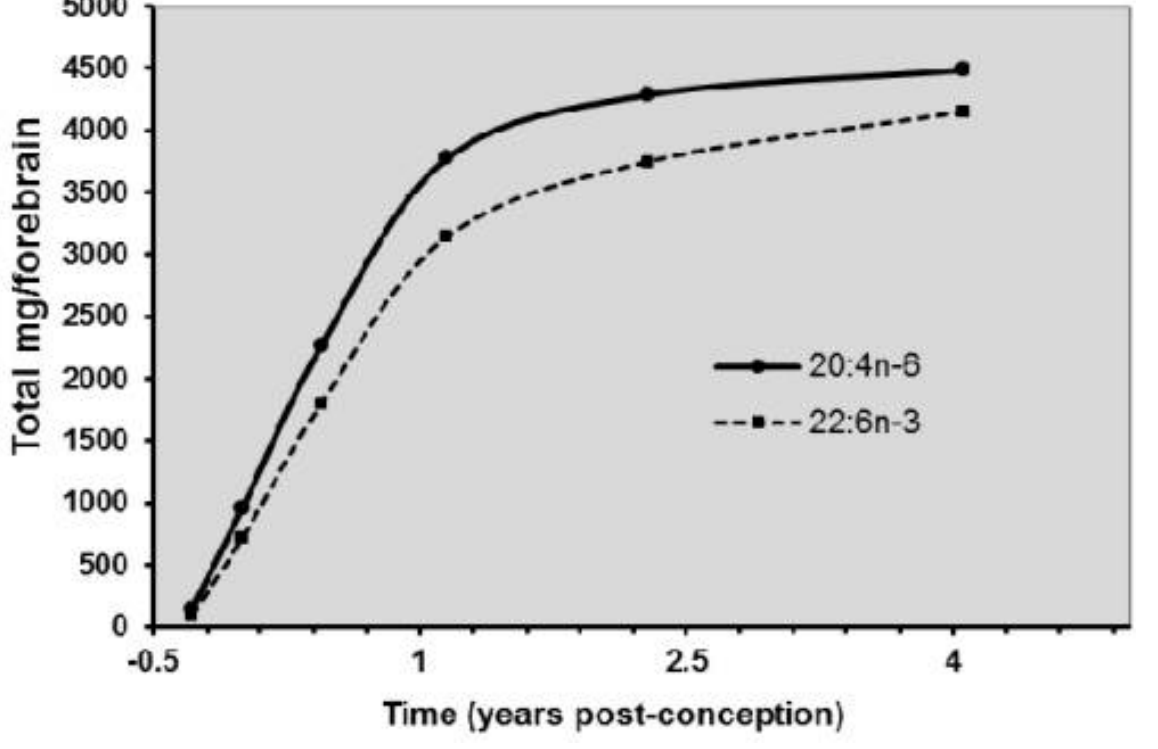
Figure 1. Accretion of docosahexaenoic acid (DHA-22:6n-3) and arachidonic acid. (AA-20:4n-6) in the brain of deceased children during the first years of life.